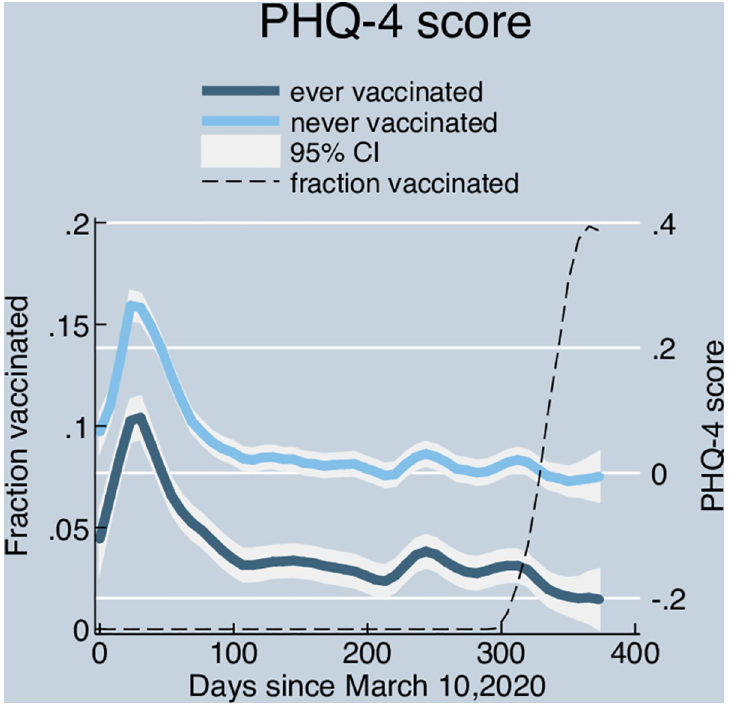
Fig 1. Trajectory of mental distress over time by vaccination group. Note. PHQ-4 scores are standardized to have a mean of 0 and a standard deviation of 1. Ever vaccinated respondents are those who reported having received at least a dose by March 14, 2021, Never vaccinated respondents are those who did not report receiving a vaccine dose between by March 14, 2021. Local polynomial approximation to date (days since the initial panel date-March 10, 2020).